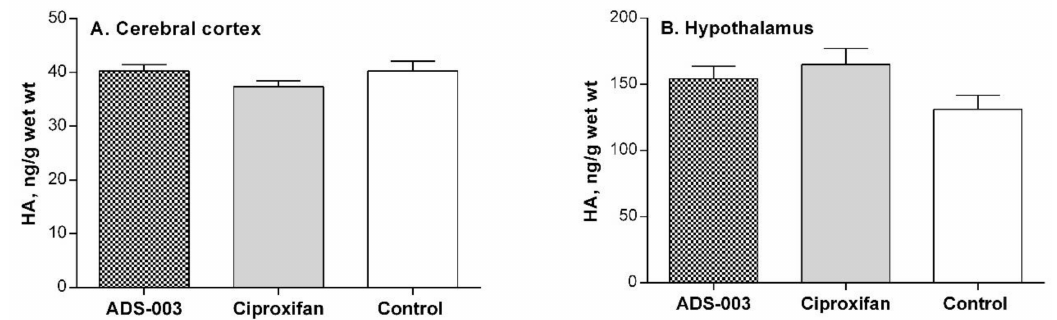
Figure 3. Cerebral histamine concentration in rats subchronically treated with Ciproxifan and the newly synthesized ADS-003 histamine H 3 receptor antagonist. The median (the line in the middle of the box) and the range of values (whiskers) are given for eight rats. Paired t -test: p < 0.05 versus “before treatment” for eight rats. Paired t -test, p < 0.05, p < 0.01 versus “before treatment”.